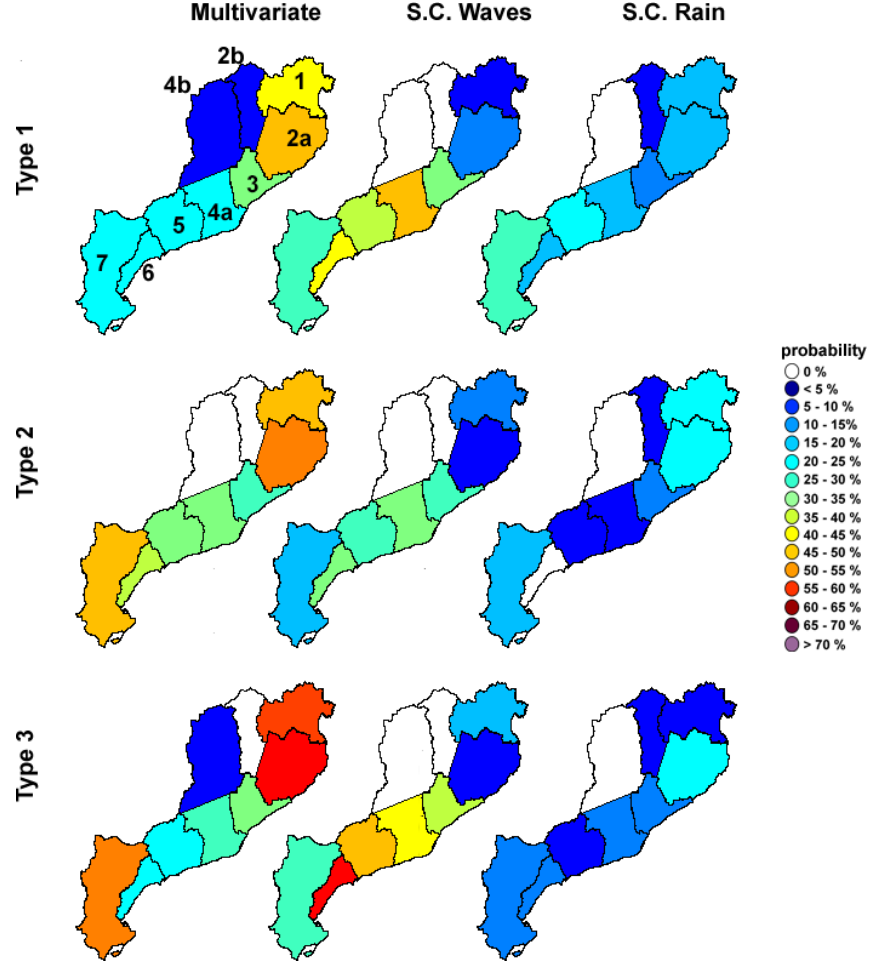
Figure 9. Spatial distribution of the probability of occurrence of the different types of compound events conditioned to each synoptic type. Probabilities are given per each area along the coast, and when adding the different types of events per area, they do not necessarily reach 100% due to cases in which neither rainfall nor wave storms locally occur. Area numbers are specified on the top left